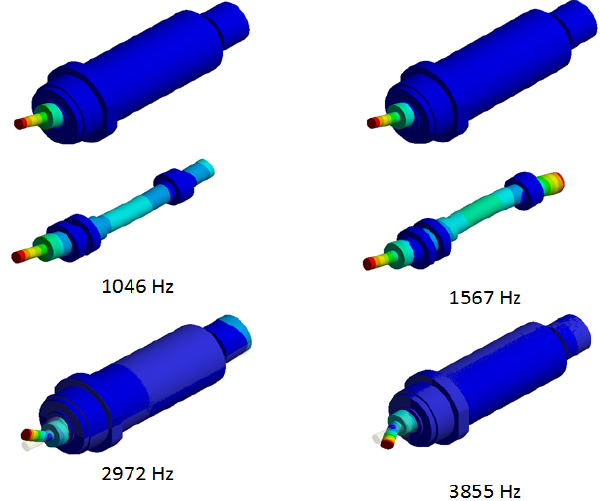
Figure 5. Fundamental modal shapes of spindle.